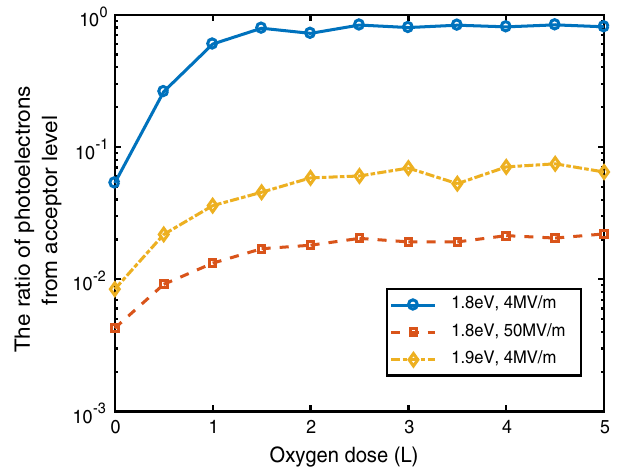
FIG. 5. The ratio of photoelectrons from acceptor level change under different conditions as shown in Fig. 4. All the results are obtained from the simulation.